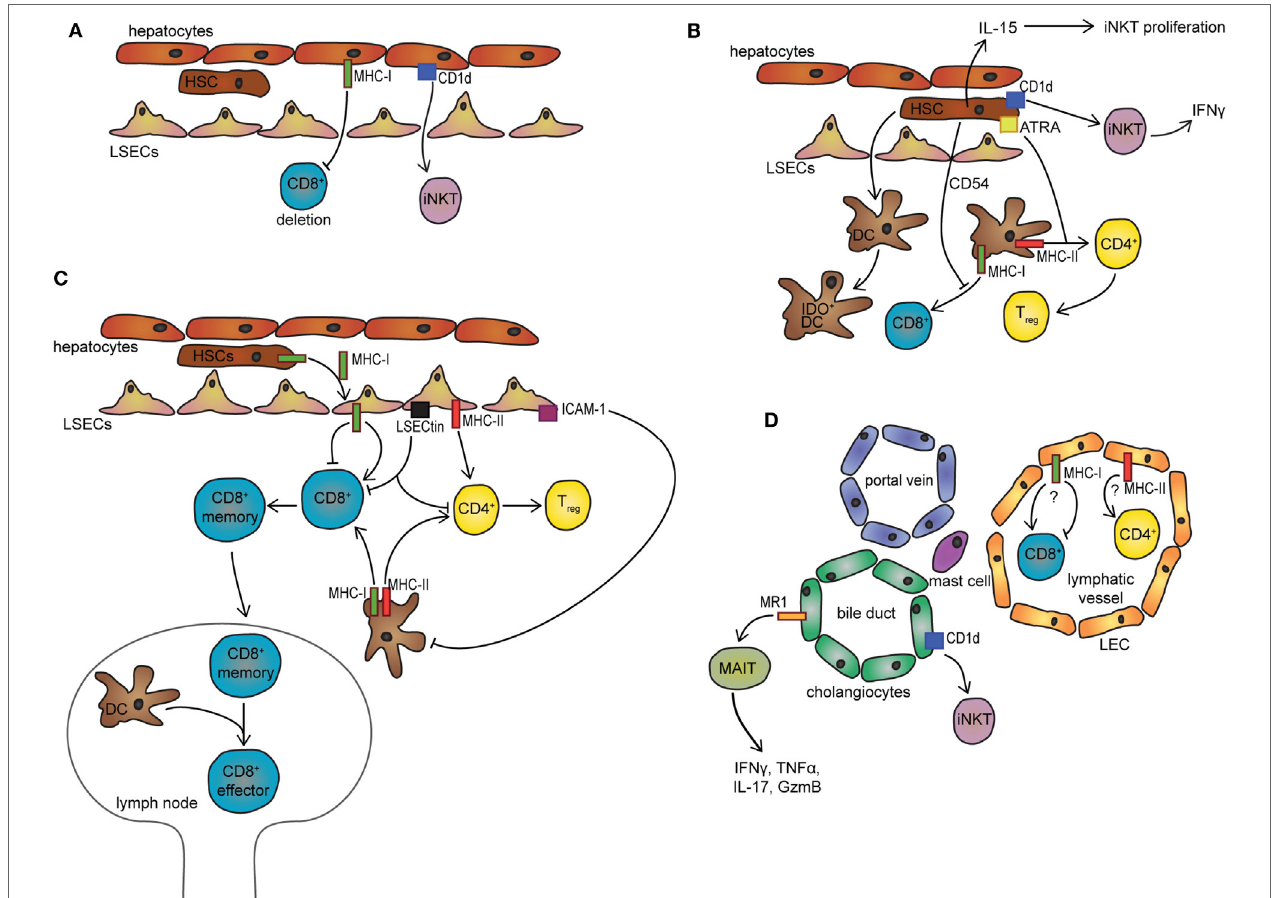
FigURe 1 | Non-professional APCs in the liver microenvironment. (A) Presentation of exogenous antigen to CD8 + T-cells by hepatocytes leads to T-cell deletion. Via CD1d, hepatocytes can activate iNKT cells. (B) HSCs inhibit DC-mediated activation of CD8 + T-cells via CD54 and promote DC-mediated differentiation of CD4 + T-cells to T regs using all-trans retinoid acid. HSCs induce IDO expression in DCs upon direct contact. Additionally, via CD1d HSCs can induce IFN γ secretion in iNKT cells and promote their proliferation by providing IL-15. (C) LSECs promote the differentiation of CD4 + T regs or CD8 + memory T-cells, respectively. CD8 + memory T-cells migrate to the lymph nodes where they can be reactivated by DCs. LSECs can inhibit DC-mediated antigen presentation via ICAM1 and inhibit T-cell activation via LSECtin. LSECs receive MHC-I antigen complexes from HSCs via transcytosis. (D) In the portal triad, cholangiocytes can activate MAIT cells via MR1 and iNKT cells via CD1d. Additionally, LECs and mast cells could represent a potential cell population with MHC-I and MHC-II antigen-presenting ability. LSECs, liver sinusoidal cells; HSC, hepatic stellate cell; ATRA, all-trans retinoid acid; LEC, lymphatic endothelial cell; MAIT, mucosal-associated invariant T-cell; DC, dendritic cell; IDO, indoleamine 2,3-dioxygenase; IL, interleukin; IFN, interferon; iNKT, invariant natural killer cell; T regs , regulatory T-cells; MHC, major histocompatibility complex; MR1, MHC class I-like-related molecule; APCs, antigen-presenting cells; LSECs, liver sinusoidal endothelial cells.